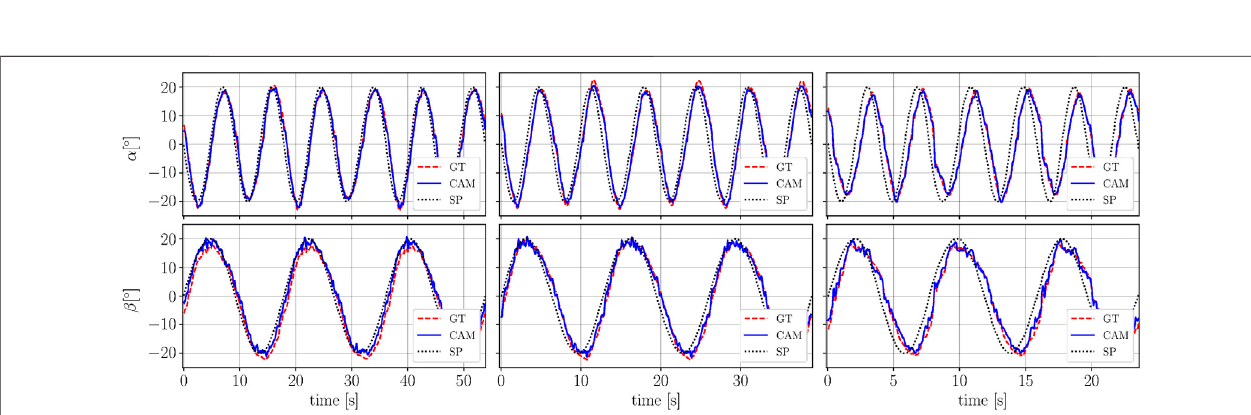
FIGURE9| The fi gure shows the resultsofthe tracking experiments withthe camera-based sensingapproachused assensoryfeedback.The angle α isshown in the top plots and β is shown in the bottom plots. The tracking experiment is performed for three different frequencies. The left hand plot shows the lowest frequency (0.12 Hz in α and 0.06 Hz in β ), the middle plot corresponds to an intermediate frequency (0.16 Hz in α and 0.08 Hz in β ) and the right hand plot shows the highest frequency (0.25 Hzin α and 0.12 Hz in β ).Thecamera-based predictions areshown inblue (solid line) and the ground truth from themotion capture in red (dashed line). The commanded setpoint is shown in black (dotted line). Slight oscillations can be observed for large absolute values of β .